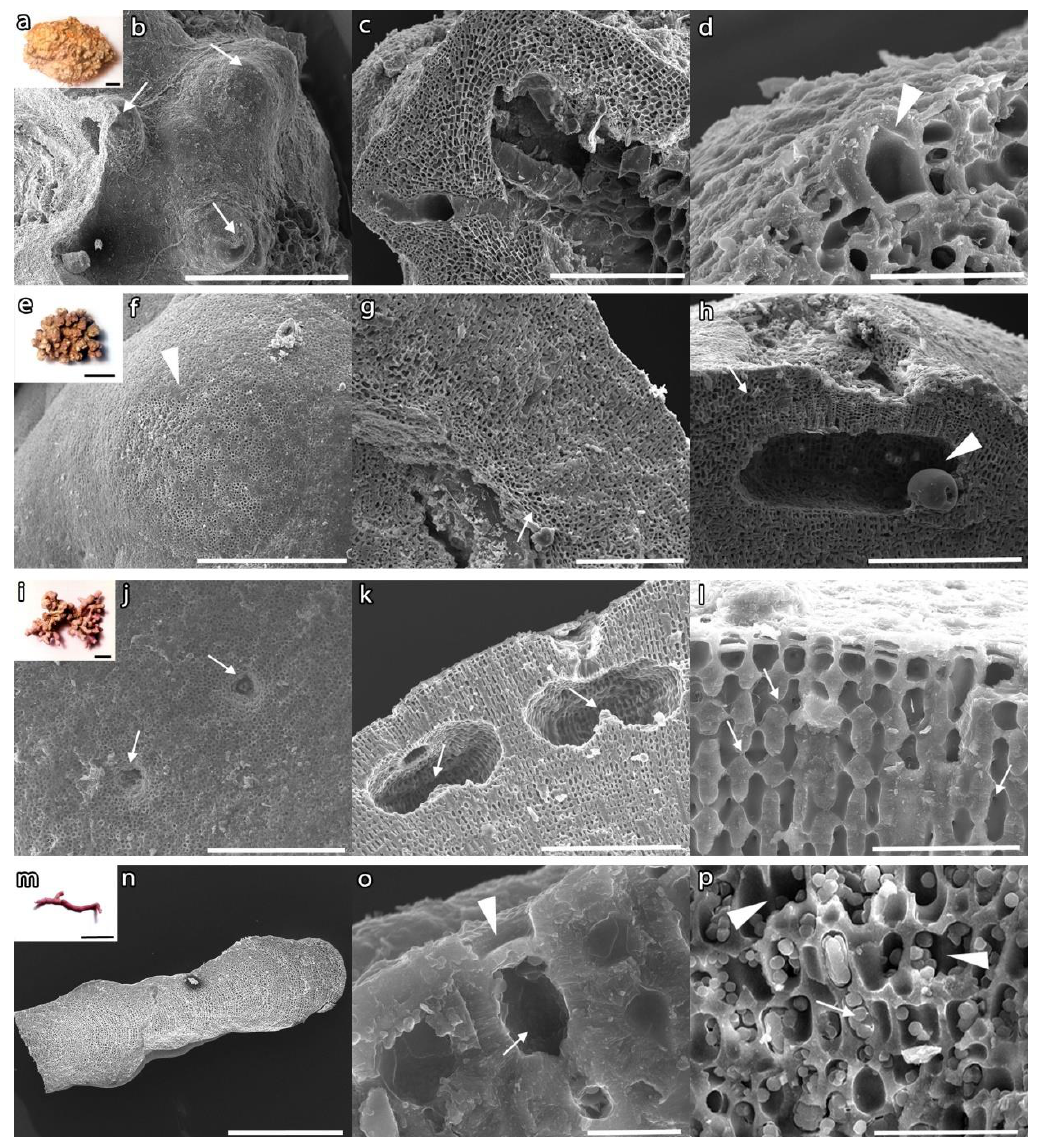
Figure 3. The three rhodolith beds identified, with detail of the morphotypes of four main species collected (pralines and boxwork at Tremiti Islands, unattached branches off Gallipoli and at Armeleia Shoal). Scale bars: 1 cm.